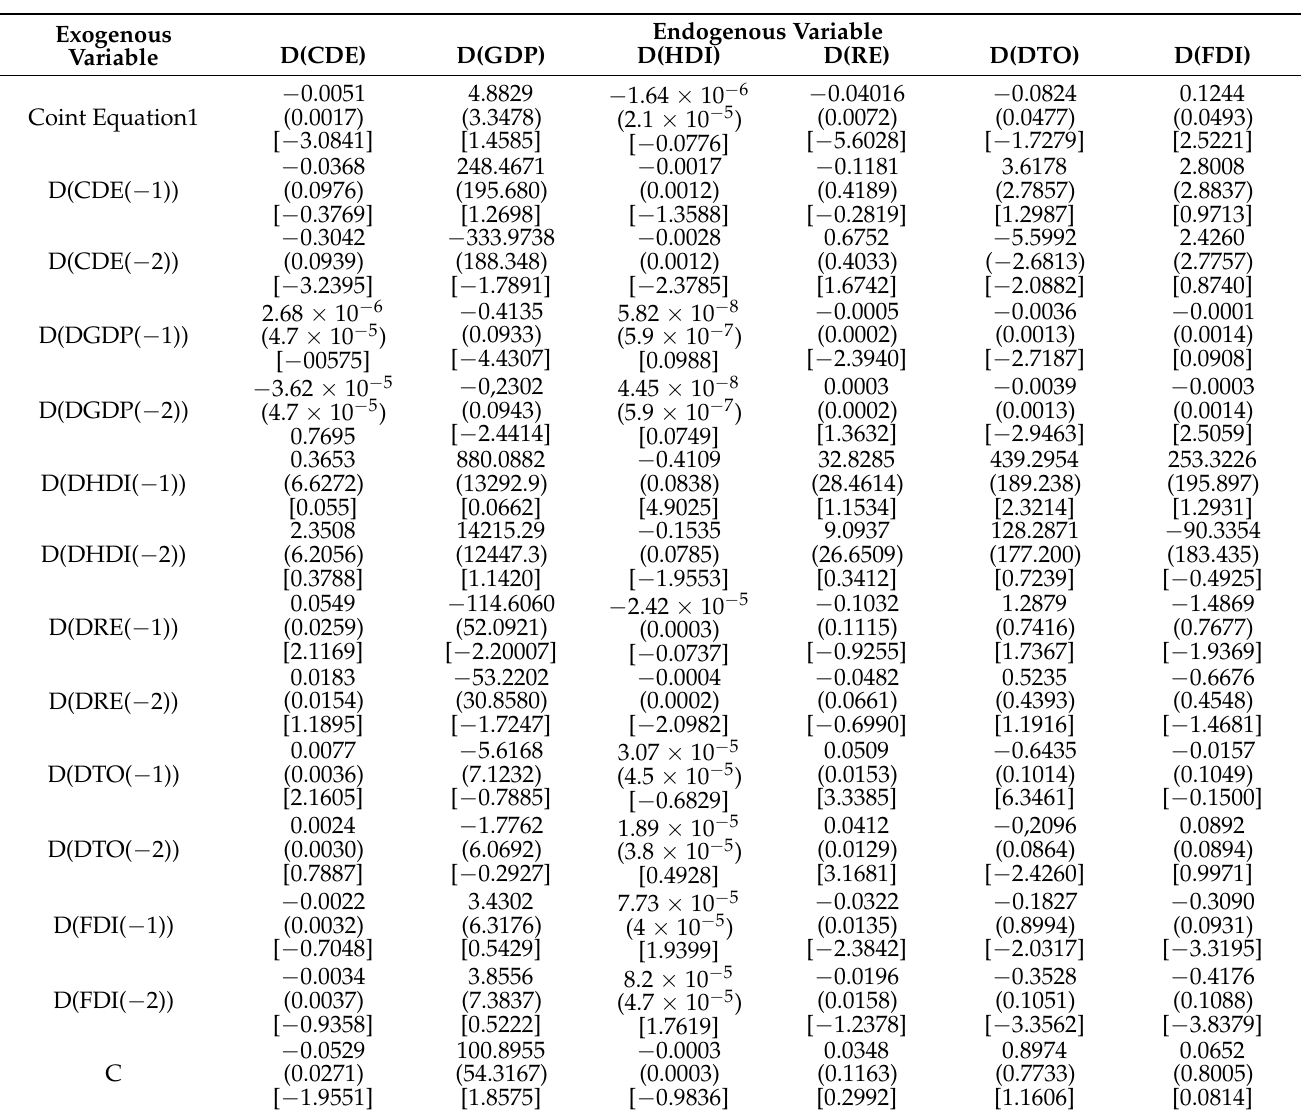
Table 8. The Summary of The Panel Vector Error Correction Model (PVECM)